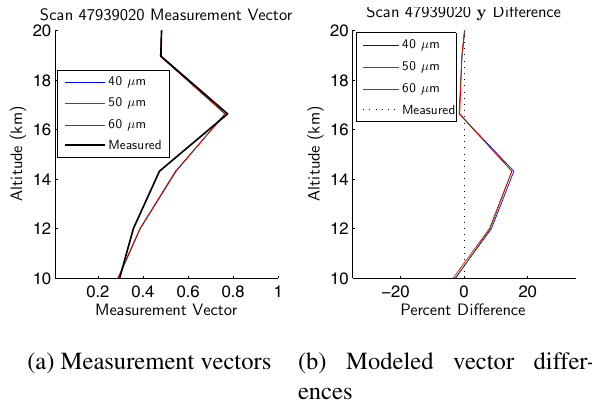
Fig. 17: Measurement vectors for OSIRIS scan 47626029. Fig. 17. Measurement vectors for OSIRIS scan 47626029. Final modeled measurement vector, F ( x (n) , ˜ b) , for the three assumed effective particle sizes are shown with the true measured vector, y , together with their percent differences with y